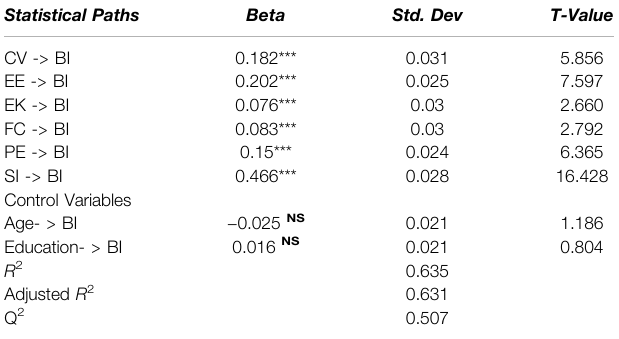
TABLE 5 | Path analysis (PLS-SEM). Statistical Paths